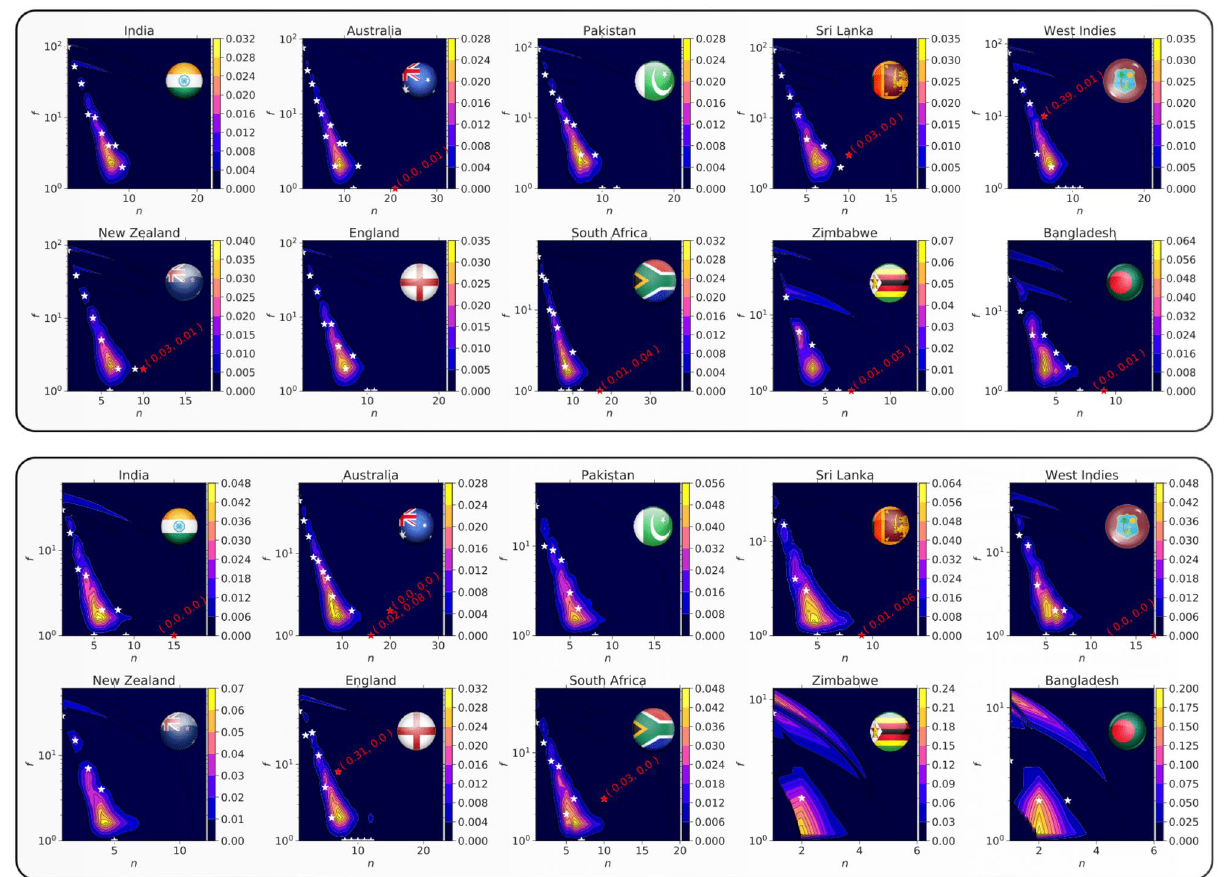
Figure 5. Hot hands in cricket teams. (top panel) ODI: Each of the 10 subplots in the figure shows the null distribution (obtained through randomly shuffling the performance sequence) of joint occurrence of winning streak length and of the corresponding frequency of occurrence. The title of each subplot provides the country of the team. Marked points on the plots represent the realized events. The white points represent the probable events, and the red points represent the extreme/unlikely events (determined through multiple testing ) (see Eq. (8) for definitions) for the unlikely events are provided along n f methods). The p values ( p ( n ) and p (cid:30) (cid:31) with the points. (Bottom panel) Test: Same as top figure for the performances in the Test